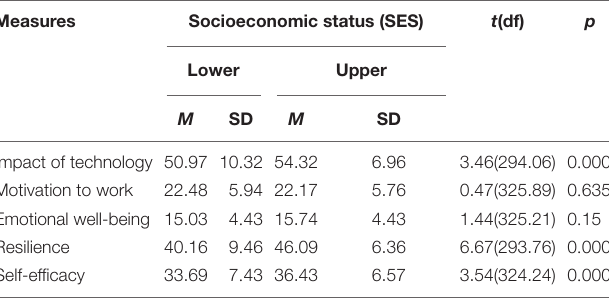
TABLE 3 | Mean comparison of scores of low and high SES groups on various measures.